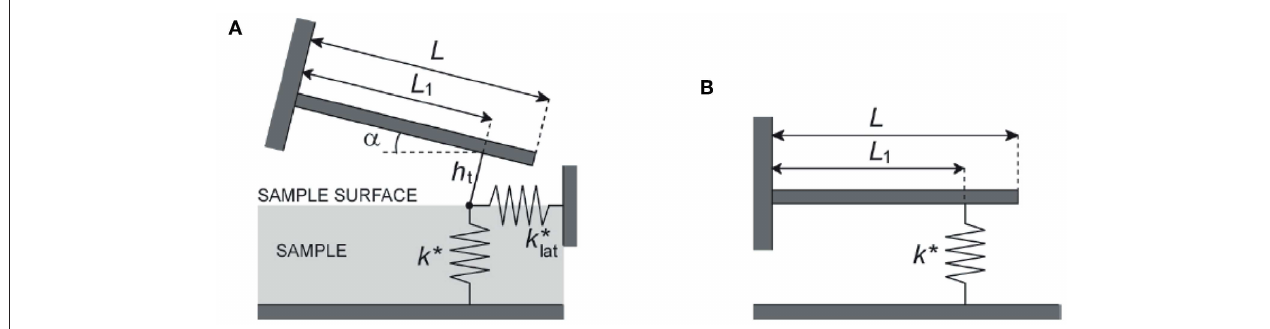
FIGURE 1 | (A) Beam model of the cantilever with length L , inclined of an angle α respect to the sample surface; the tip is located at distance L 1 from the cantilever clamped end, its height being h t ; the tip interacts with the sample surface via both normal and lateral forces, and the contact is thus described by the normal and lateral contact stiffness modeled through the linear springs k ∗ and k ∗ lat , respectively. (B) Simplified beam model of the cantilever, supposed parallel to the sample surface; the tip, the height of which is neglected, interacts with the sample only through normal forces modeled by the contact stiffness k ∗ . Reprinted and adapted from Passeri et al.